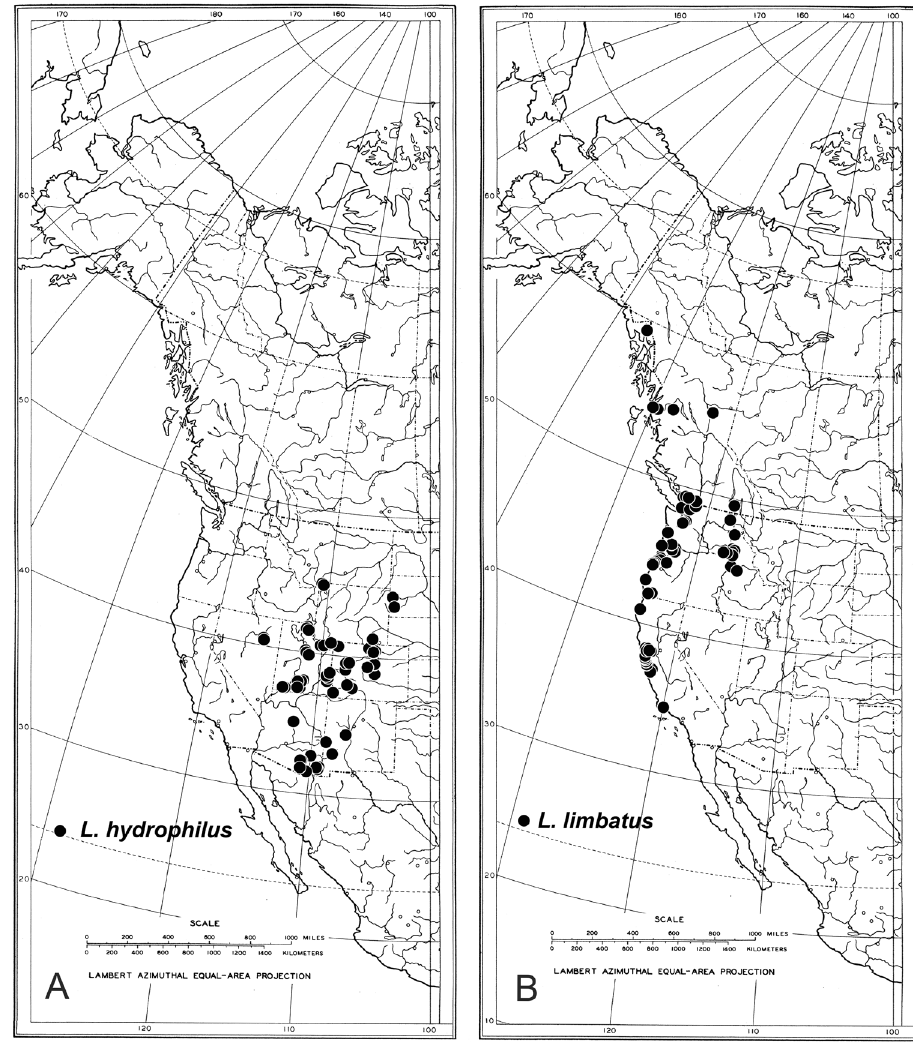
Figure 14. Known distributions of A Liancalus hydrophilus Aldrich and B L. limbatus Van Duzee.